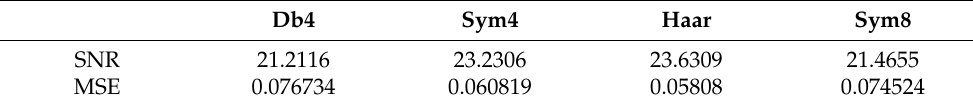
Table 3. Comparison of the denoising effect of several commonly used wavelet bases.